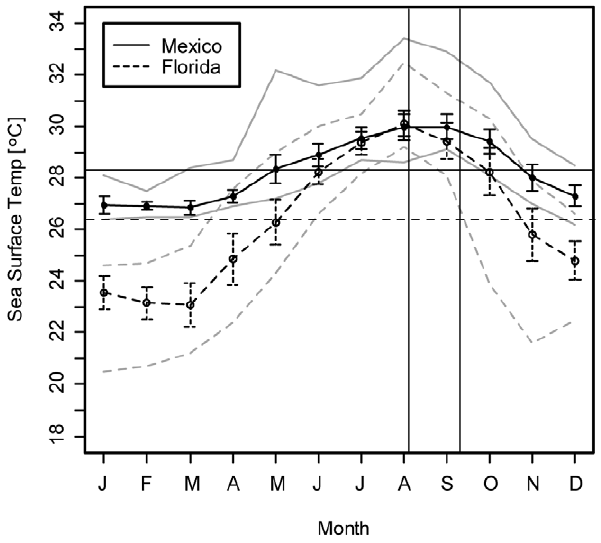
Figure 2. Mean monthly sea surface temperatures from 2005 to 2008 for the two study locations (Mexico and Florida). Horizontal lines represent annual means. Area within the vertical lines delineates the spawning season for M. faveolata . Error bars indicate 6 1 standard deviation. Grey lines represent monthly maxima and minima. Data from NOAA weather buoys MLRF1 and 42056.